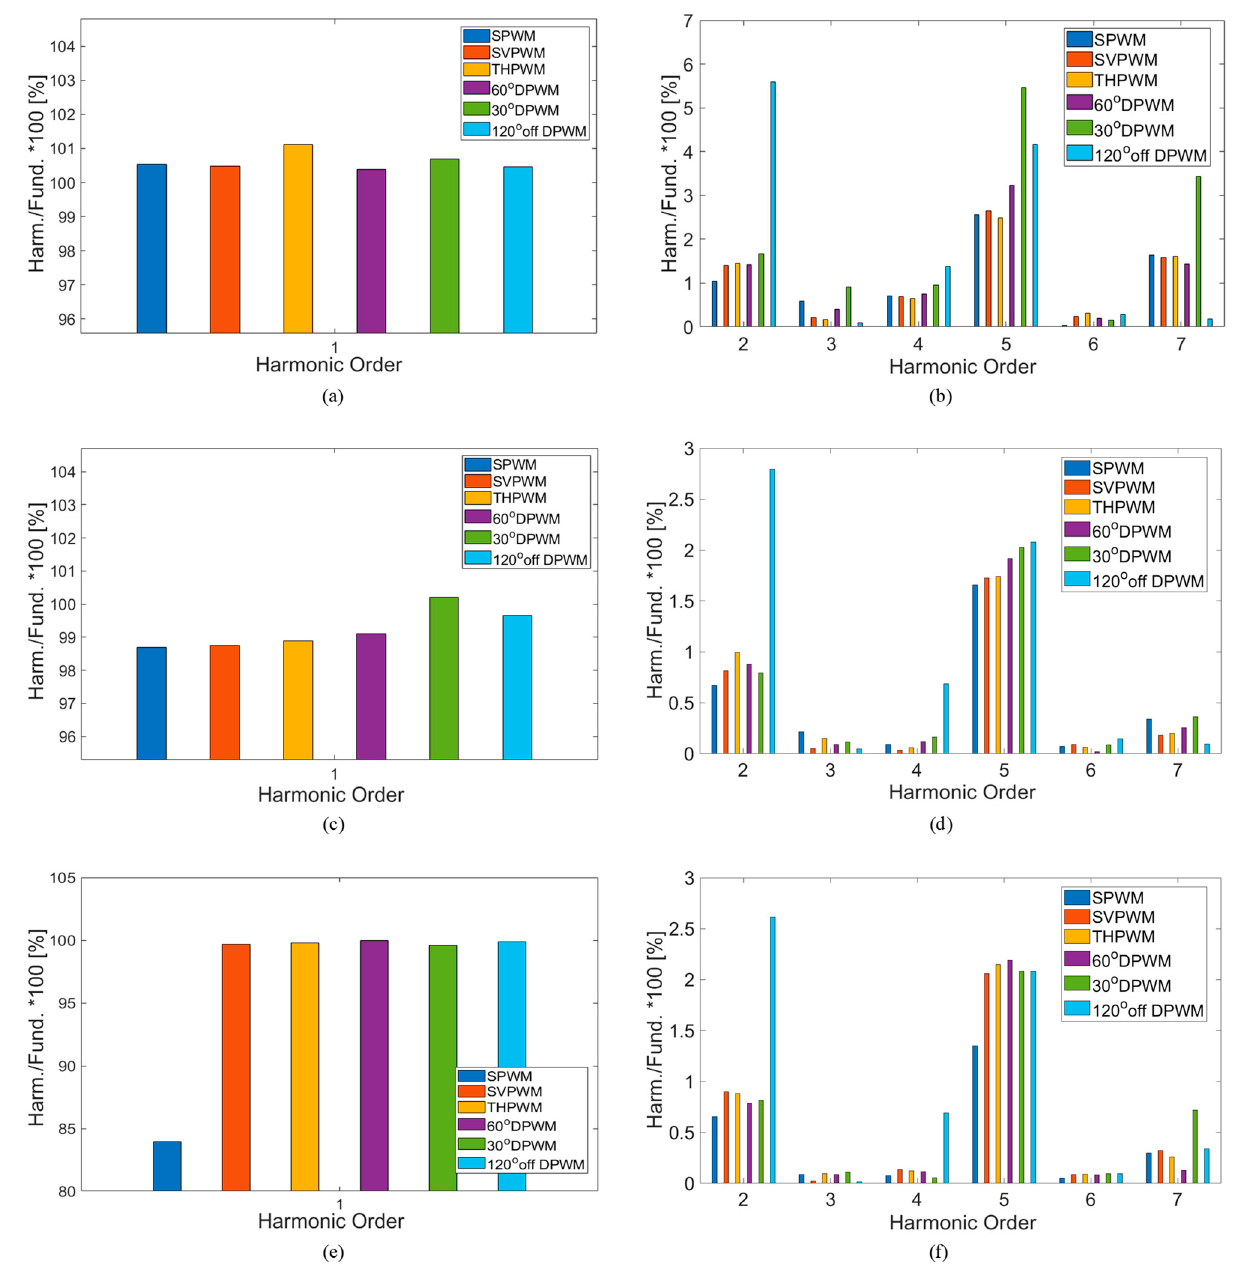
Figure 18. Spectrum of phase current depending on the PWM technique: ( a ) fundamental component at 400 rpm and 1.5 A; ( b ) harmonics at 400 rpm and 1.5 A; ( c ) fundamental component at 1000 rpm and 3 A; ( d ) harmonics at 1000 rpm and 3 A; ( e ) fundamental component at 1200 rpm and 3 A; ( f ) harmonics at 1200 rpm and 3 A.